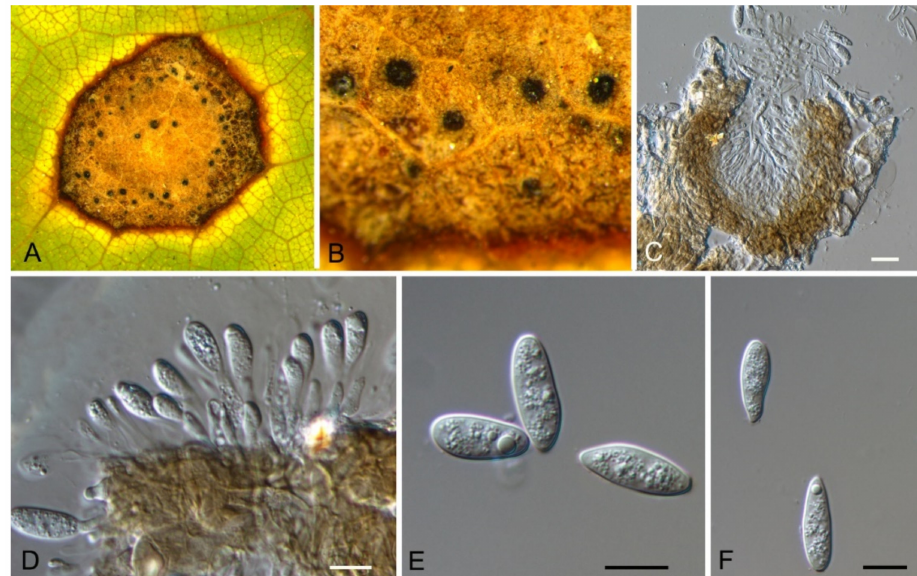
Figure 2. Botryosphaeria dothidea (BJFC-S1797). ( A , B ) Conidiomata on the diseased leaves of Castanea mollissima ; ( C ) Section through the pycnidium; ( D ) Conidiogenous cells giving rise to conidia; ( E , F ) Conidia. Scale bars: ( C ) = 15 µ m; ( C – F ) = 10 µ